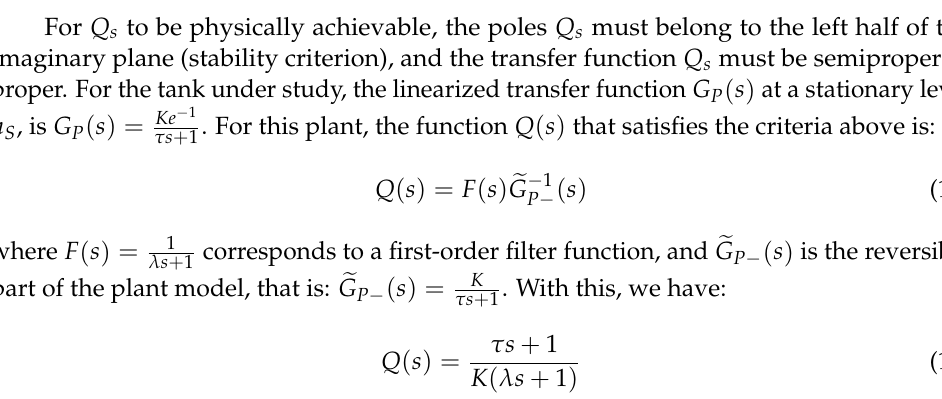
Figure 5. Typical block diagram for the IMC controller.